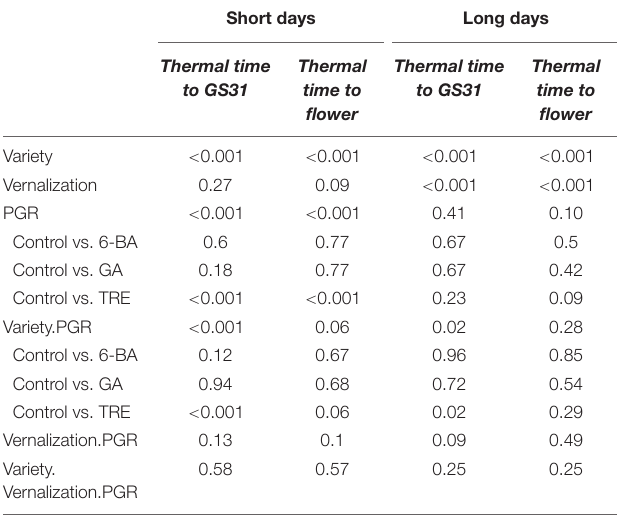
TABLE 6 | Statistical analysis of interactions between day length, variety, vernalization, and PGR treatment in Experiment